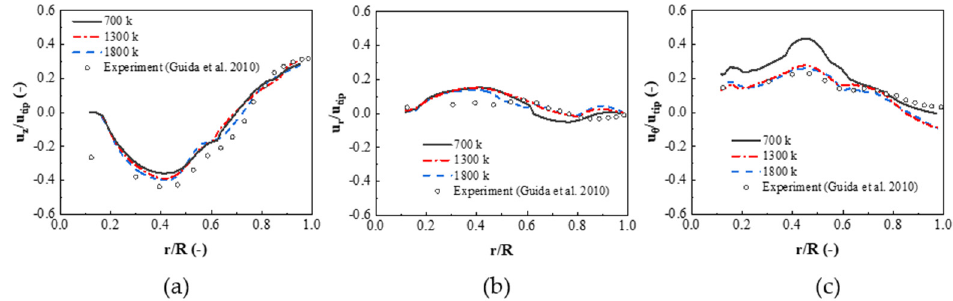
Figure 7. Comparison of radial profiles of solids velocity with experimental results ( z = 0.2 H ). ( a ) Axial velocity component u z , ( b ) radial velocity component u r , ( c ) tangential velocity component u θ .